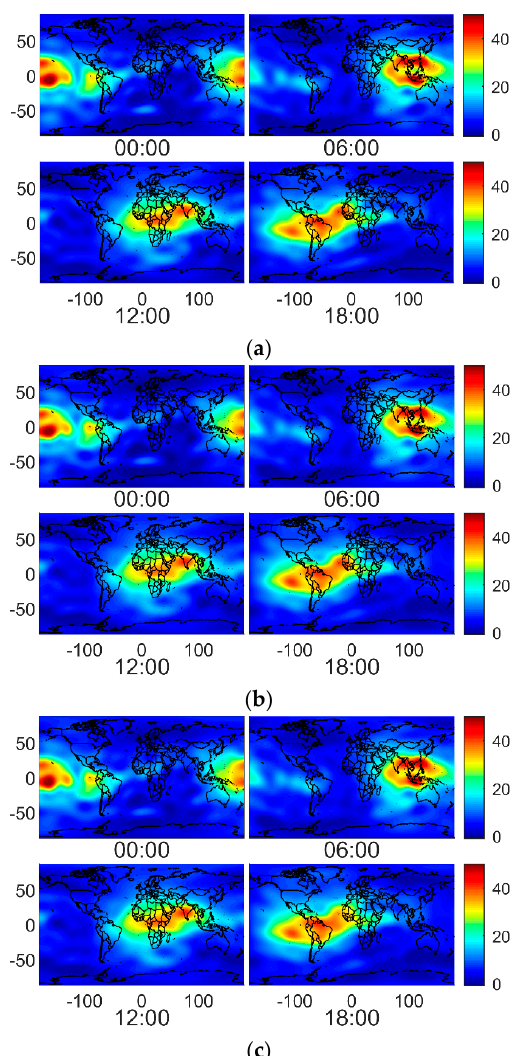
Figure 5. Grid map of VTEC values in the global area on 10 April 2017 (DOY 100, 2017) for the CCL ( a ), PPP-float ( b ), and PPP-AR ( c ) methods on DOY 100, 2017.